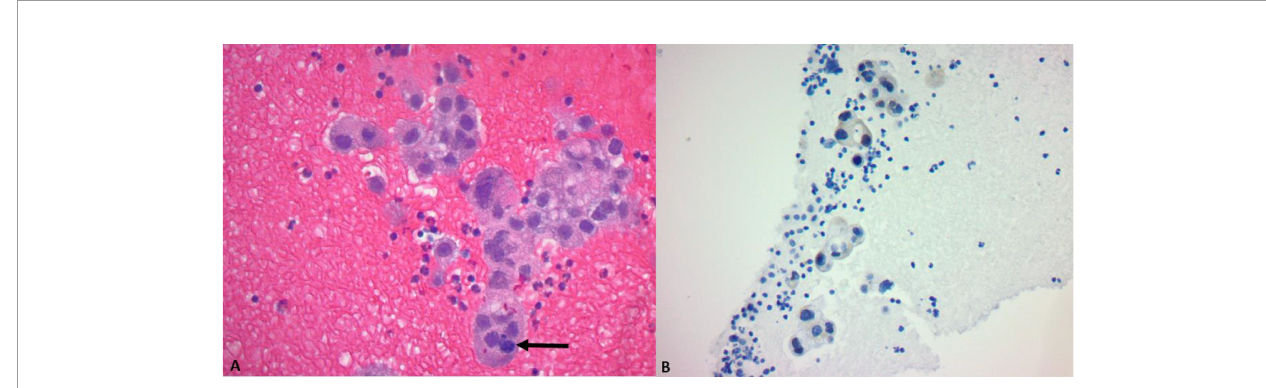
FIGURE 2 | (A) H&E ×40: Poorly forming glands with vacuolated cytoplasm, hyperchromatic and pleomorphic nuclei, and an identi fi able mitosis (arrow). (B) TTF1 stain: a cluster of tumor cells shows nuclear